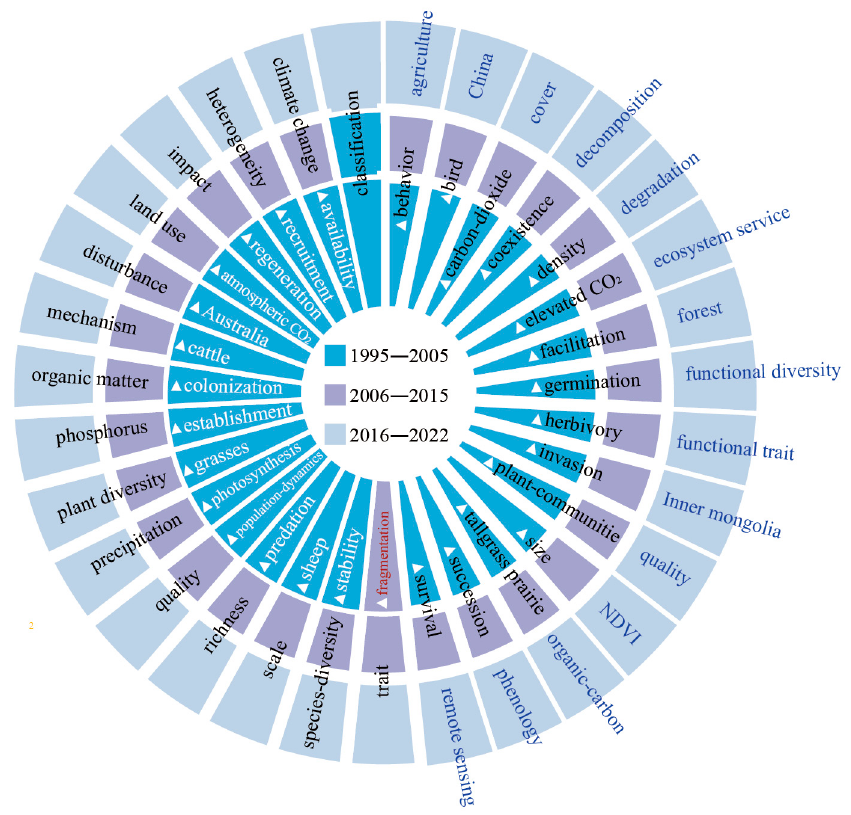
Figure 6. The keywords evolution and change of grassland ecosystem from 1990 to 2005, 2006 to 2015, and 2016 to 2021 (blue text indicated keywords that appeared only from 2016 to 2021; red text indicated keywords that appear only from 2006 to 2015; white text indicated keywords that appeared only from 1995 to 2005; white text marked with a triangle represented the disappearance of keywords; black text indicated the keywords that appeared in two time periods simultaneously, and the location indicates the covering time period).